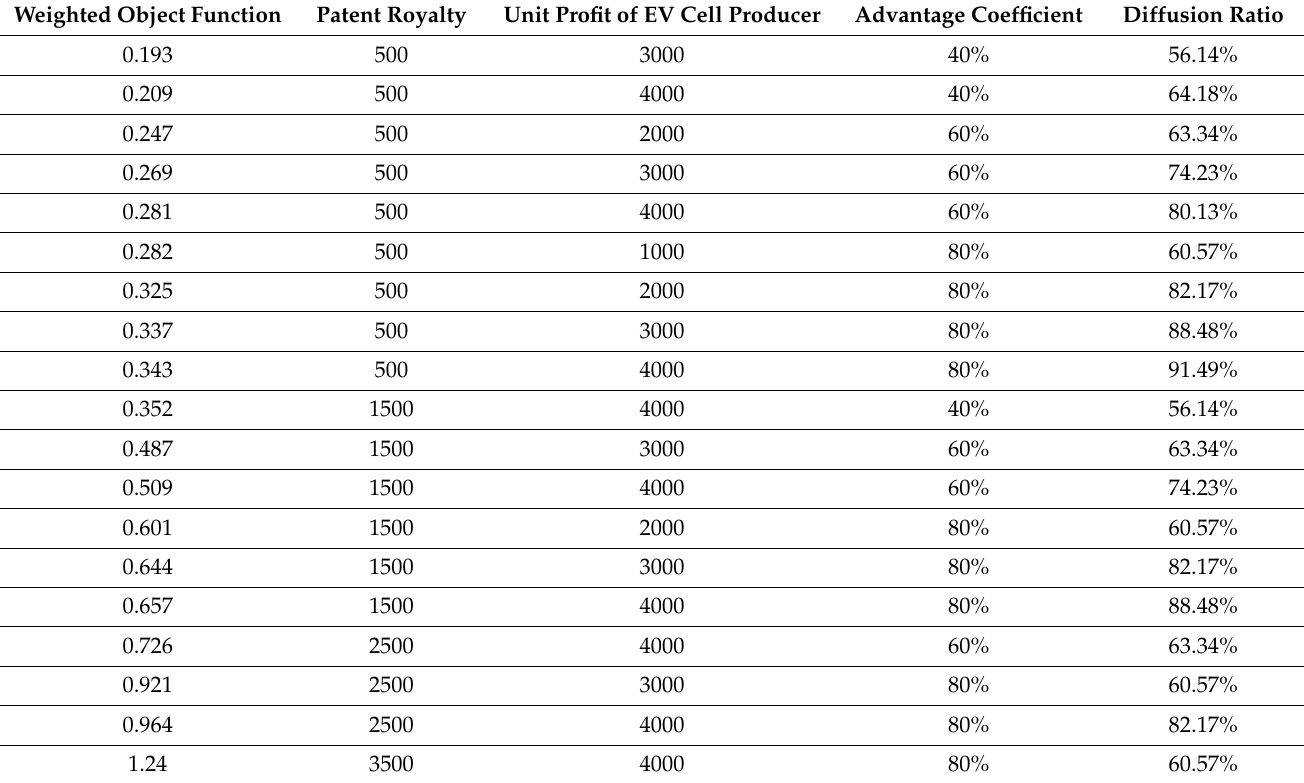
Table 6. Local and global optimization object function of EV patent